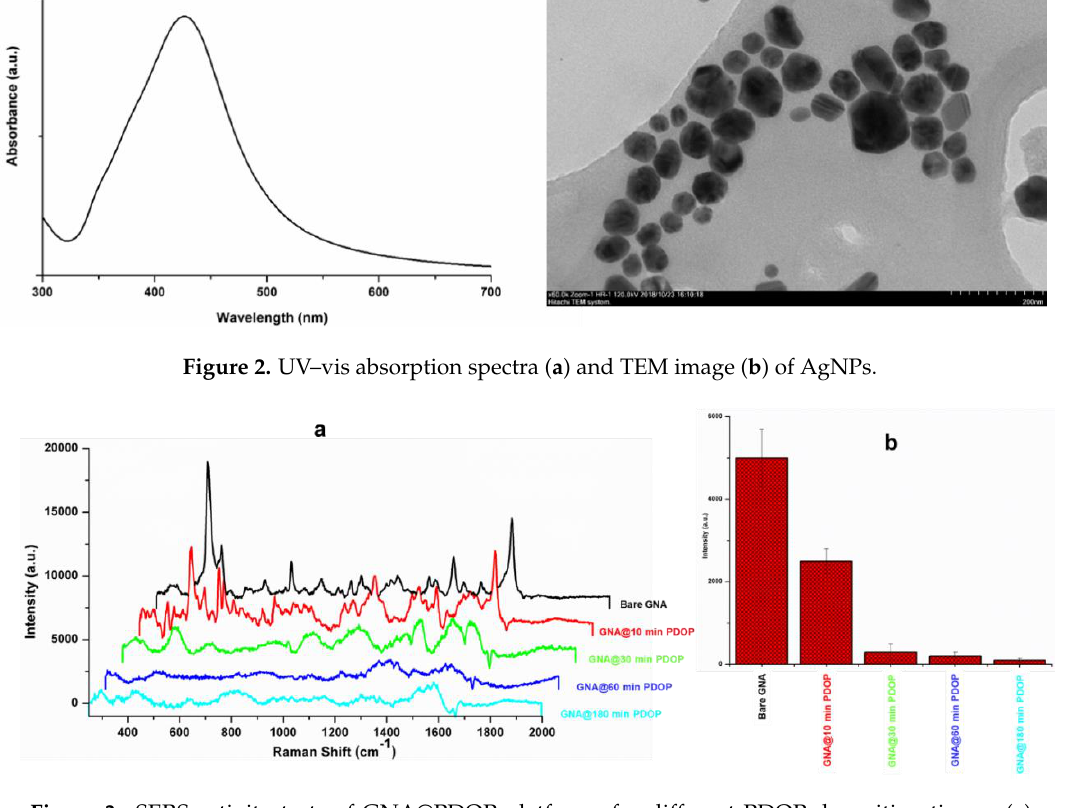
Figure 3. SERS activity tests of GNA@PDOP platforms for different PDOP deposition times. ( a ) Representative SERS spectra for each platform; ( b ) the intensity histogram of different platforms for prominent peak of MB at 1620 cm −1 .